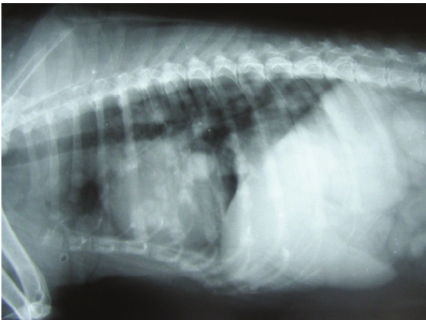
Figure 31: Sagittal sonogram (2D) of liver in a ten-year-old intact Labrador retriever dog a ff ected by a perianal tumour showing hyperechoic hepatic mass with central lytic changes.